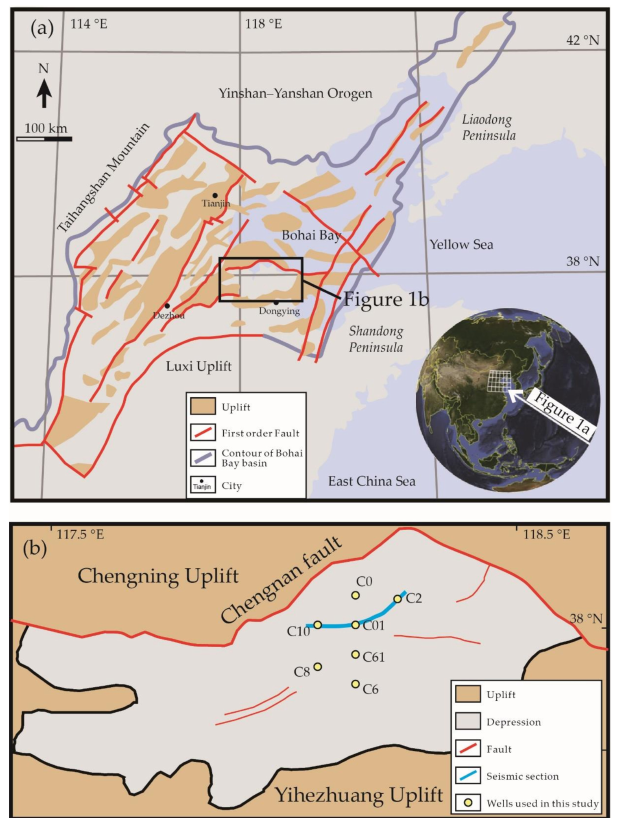
Figure 1. ( a ) A simplified tectonic map of the Bohai Bay basin, modified from Li et al. (2011) [31]. ( b ) A simplified geological map of the Chezhen depression, modified from Lao et al. (2011) [3]. It should be noted that the logging data from the seven wells (yellow points) were used in most results; however, the reconstruction of the paleogeomorphologic map was performed based on all 40 wells in this region. The locations of the other 33 wells are hidden in this map following privacy